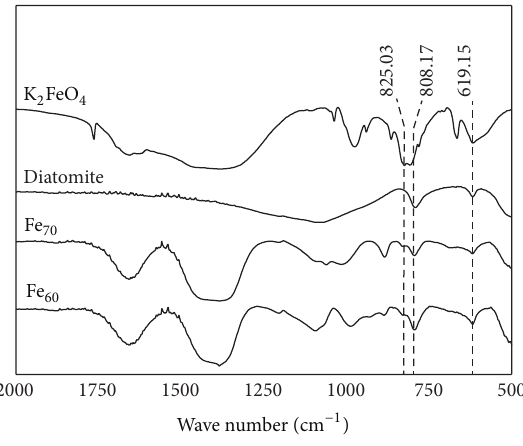
Figure 3: FT-IR spectra of Fe 70 , Fe 60 , K 2 FeO 4 , and diatomite samples.